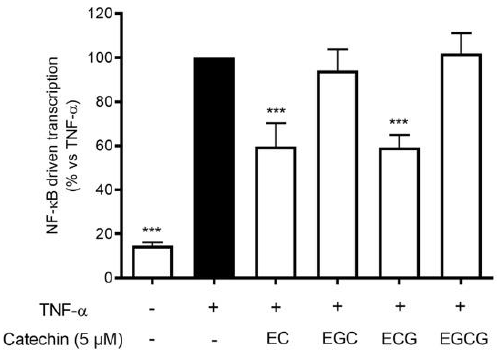
Figure 7. Effect of catechin treatment (5 µ M) on the NF- κ B-driven transcription in HaCaT cells induced by TNF- α (10 ng/mL) for 6 h. The reference inhibitor apigenin (20 µ M), representing the positive control, abrogated the NF- κ B-driven transcription and inhibited the release of IL-8 ( − 99%). The amount of IL-8 in the stimulated condition was 426.41 ± 96.97 pg/mL. *** p < 0.001 vs. stimulus.